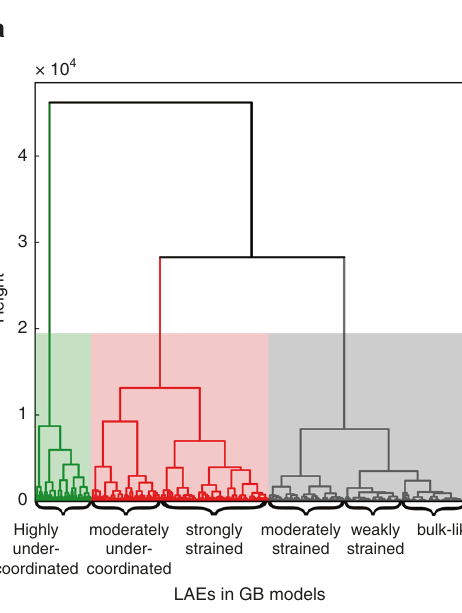
Fig. 2 Local distortion factors, LDFs, obtained using the SOAP descriptor. a LDFs of all LAEs in tilt and twist GB models in order of increasing tilt or twist angle for each class of rotation axis. One vertical column of LDFs corresponds to one GB model. b LDFs of atoms in an isotropically expanded unit cell as a function of bond elongation and volume expansion.